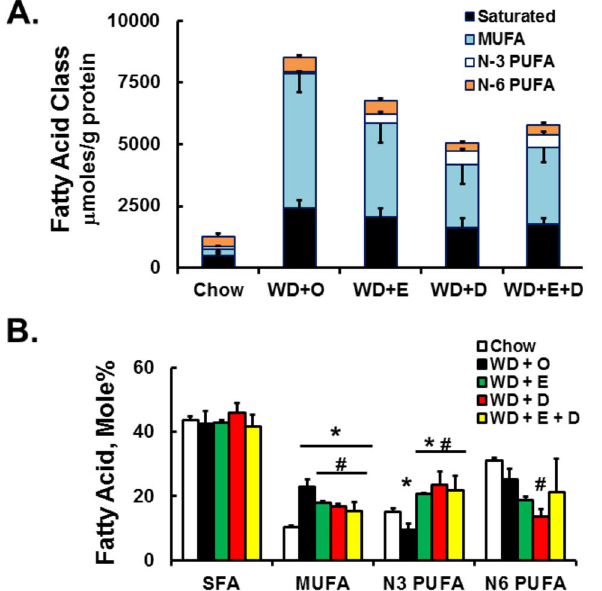
Figure 10. Diet effects on hepatic fat content. Panel A: Abundance of total hepatic SFA, MUFA, n-6 PUFA, and n-3 PUFA fatty acids analyzed from total lipid extracts using gas chromatography [8]. The sum of the fatty acids in each group (SFA, MUFA, n-3 and n-6 PUFA) is presented to illustrate the cumulative effects of diet on hepatic fat. Results are presented as total µmoles of fatty acid/g protein; mean + SD in each fatty acid class; n=8/group. Panel B: Distribution of SFA, MUFA, n-6 PUFA, and n-3 PUFA in hepatic phospholipids. Hepatic phospholipids were fractionated by solid phase separation, saponified and methylated for GC analysis (see Fig, S1 for the quality of the separation of phospholipids from total lipids). Results are expressed as Fatty Acid Mole% in each fatty acid class, i.e., SFA, MUFA, N3 and N6-PUFA; mean + SD, n=8/ group. doi: 10.1371/journal.pone.0083756.g010 Figure 11. Diet effects on hepatic phospholipid fatty acids. Individual fatty acids in the phospholipid fraction were quantified as described above and represented as Fatty Acid- Mole%, mean + SD, n=8/group; *, P ≤ 0.05 versus chow; #, P ≤ 0.05 versus WD + O.